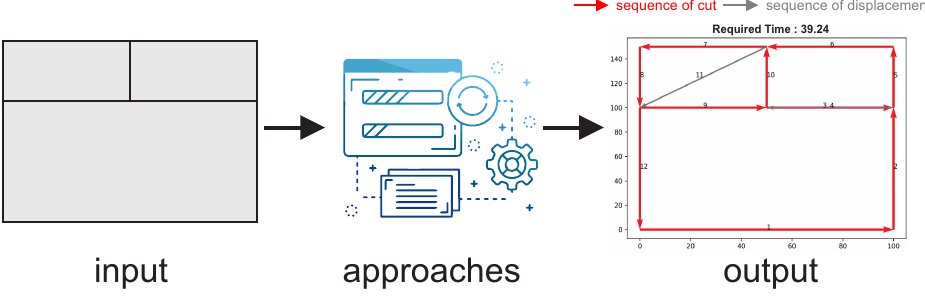
Figure 10. Input and output representation.